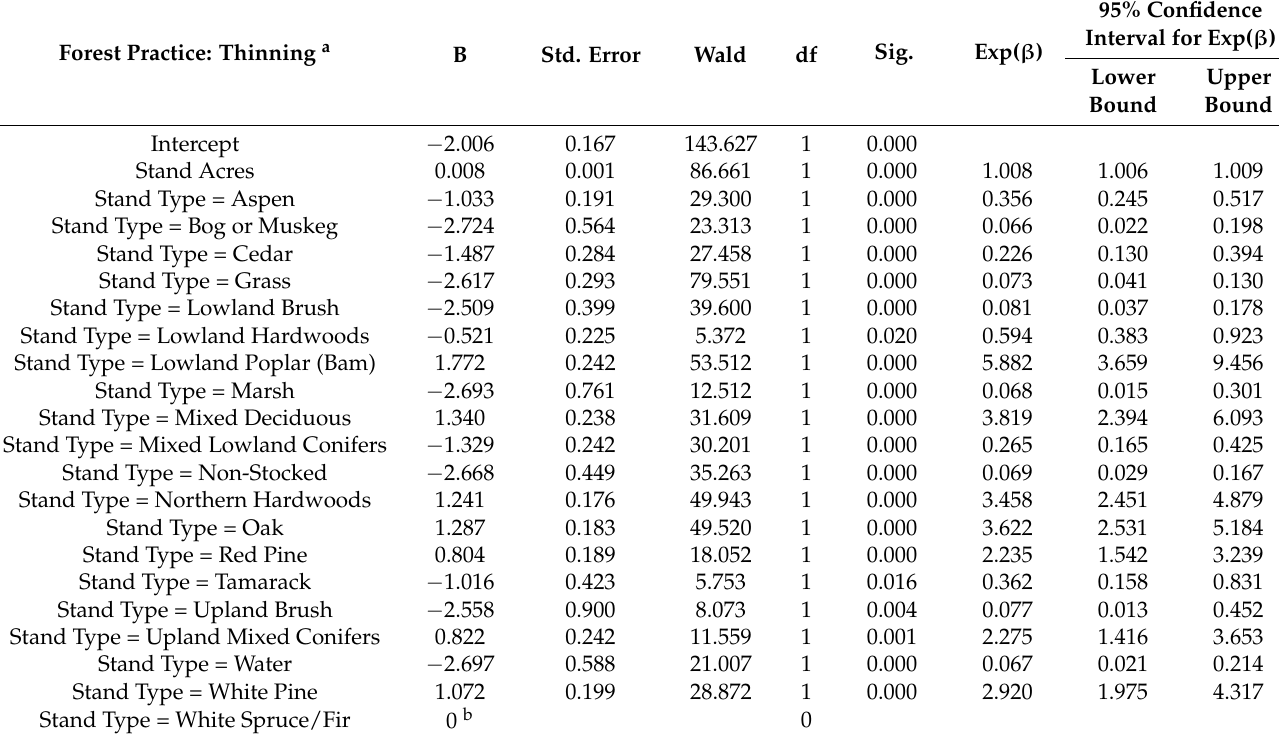
Table 6. Multinomial logistic regression parameter estimates for significant results predicting the forest practice ‘Thinning.’ Stand acres and stand type as independent variables (showing results from thinning). N = 20,915 unique forest stands that are enrolled in the Qualified Forest